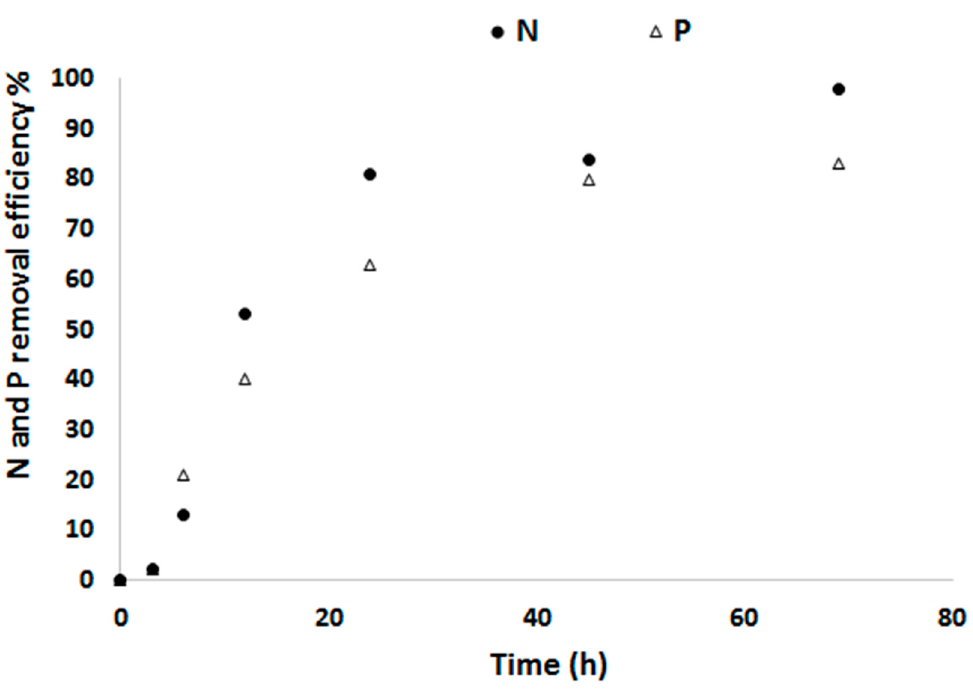
Figure 3. N and P removal efficiency of C. sorokiniana as grown in the defined medium .